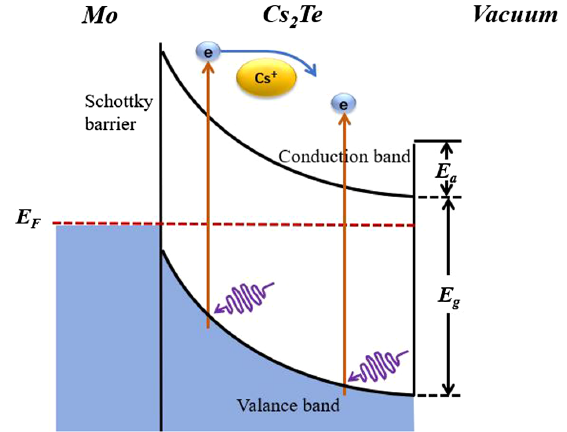
FIG. 4. The correlation of TMS and QE of four Cs 2 Te